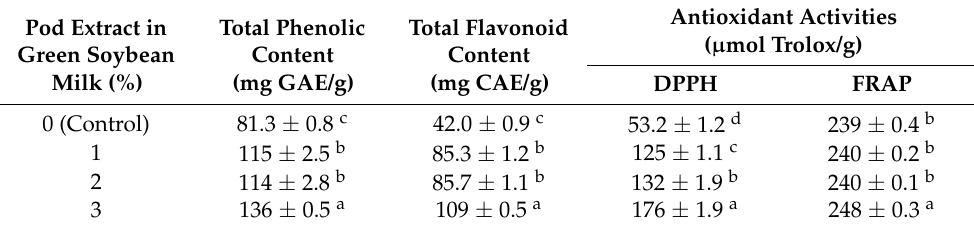
Table 3. The content of phenolic and flavonoid, antioxidant activities of green soybean milk fortified with pod